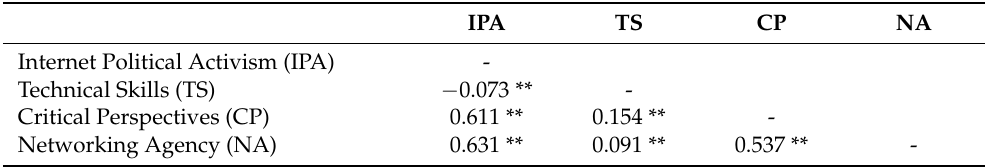
Table 3. Pearson correlations between